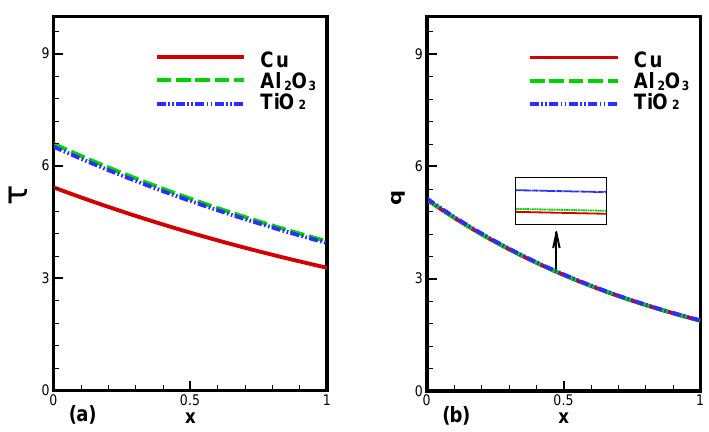
Figure 7. Variation of different nanoparticles on dimensionless ( a ) wall shear stress and ( b ) heat transfer rate, when β = 1, R e = 1, δ = 0.2, B r = 6, P e = 1, φ = 0.05, and γ = 0.2.